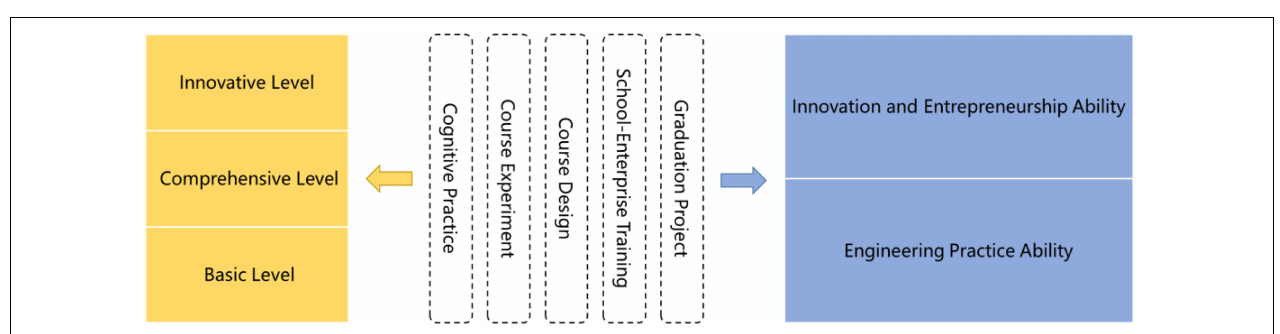
FIGURE 3 | Curriculum system of IoT Engineering.